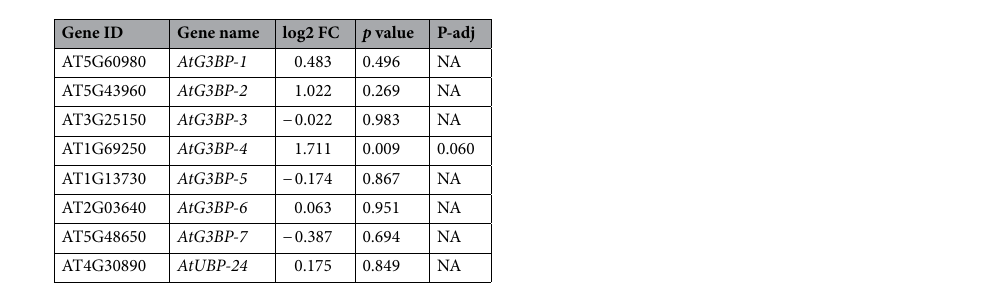
Table 2. RNAseq data for the different AtG3BPs and AtUBP-24 in TuMV-RFP infection sites at 2 dpi compared to the mock-treated